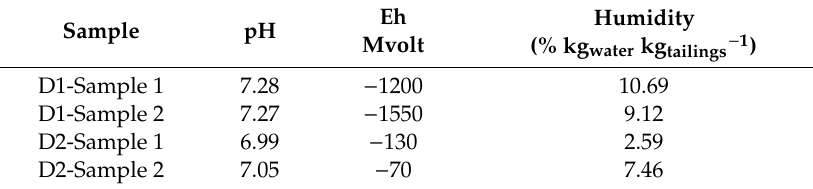
Table 5. Mine tailings sample measurement